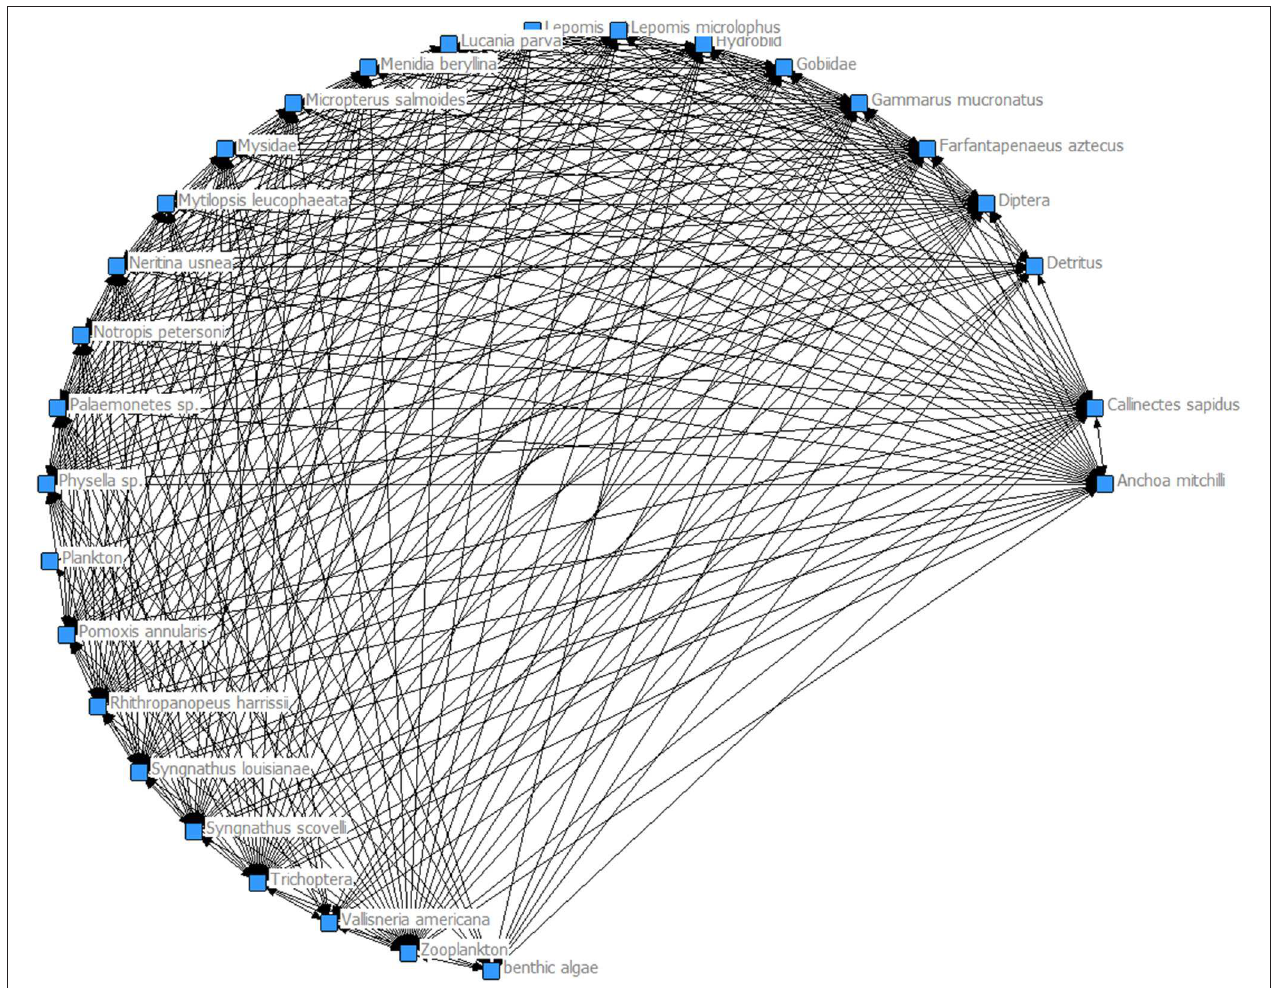
FIGURE 3 | Network model using existing data for Vallisneria americana